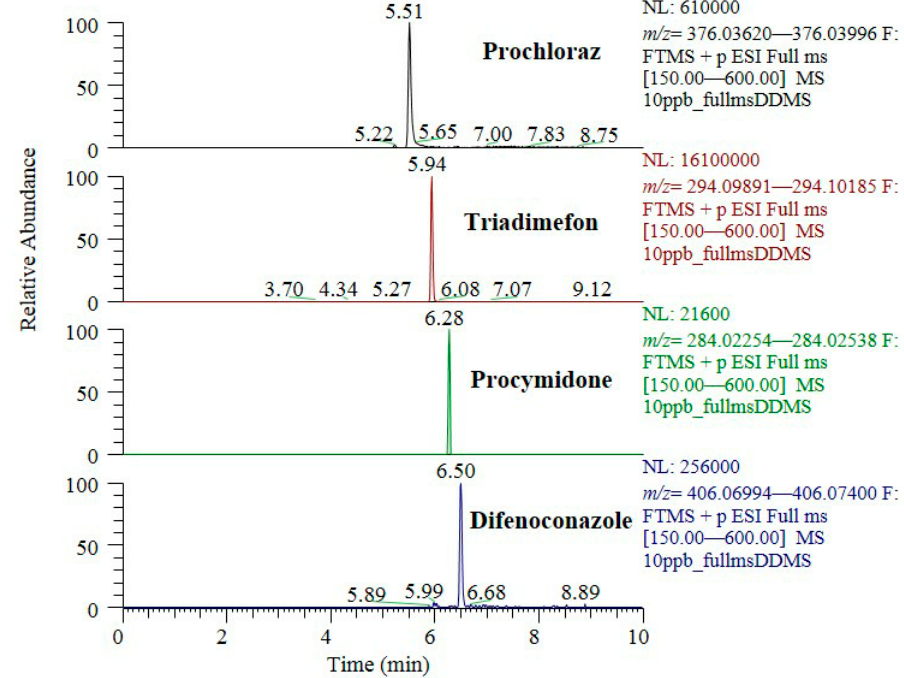
Figure 3. SIM chromatogram of nine target fungicides at 10.0 µ g/L. NL: normalized level, FTMS: Fourier-transformed mass spectrometry, ESI: electrospray ionization, MS: mass spectrometry, DDMS: data-dependent mass spectrometry.